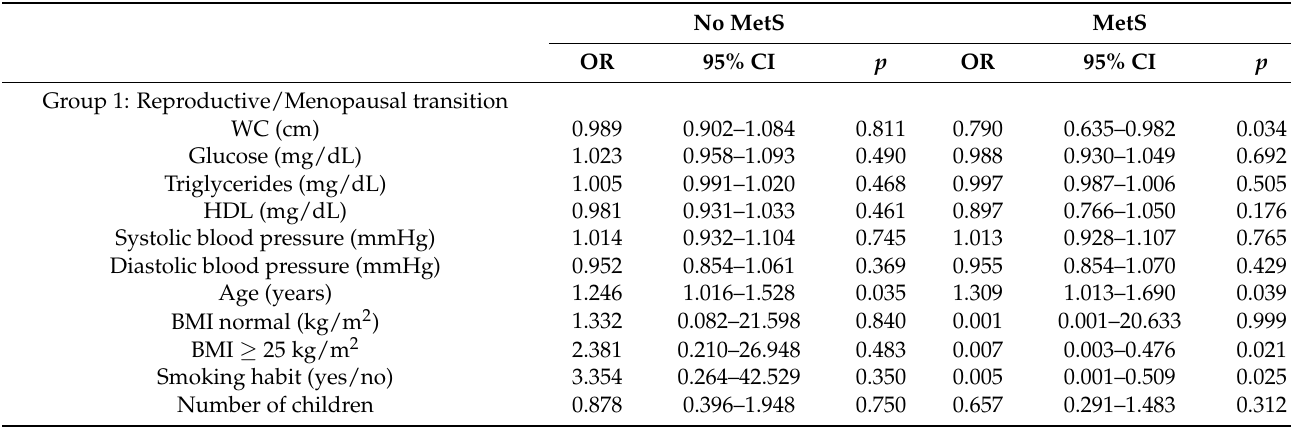
Table 3. Multivariate logistic regression analysis of low bone mineral density (osteopenia/osteoporosis) in the spine in 40–60-year-old